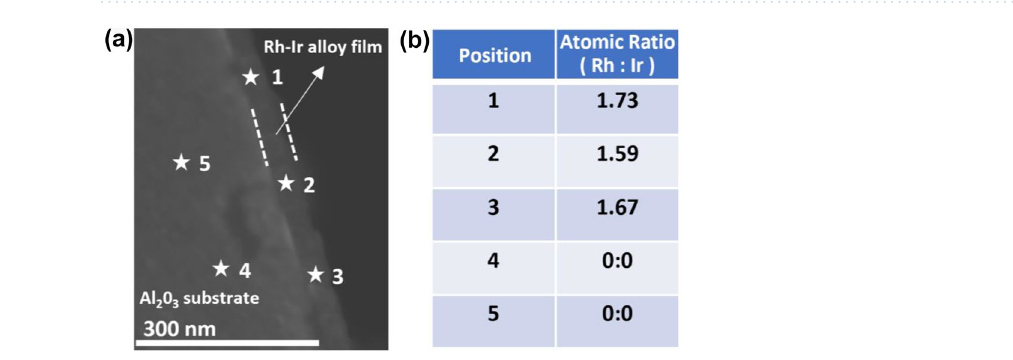
Figure 4. ( a ) Cross-sectional SEM image and ( b ) point elemental analysis of Rh–Ir alloy thin film on Al 2 O 3